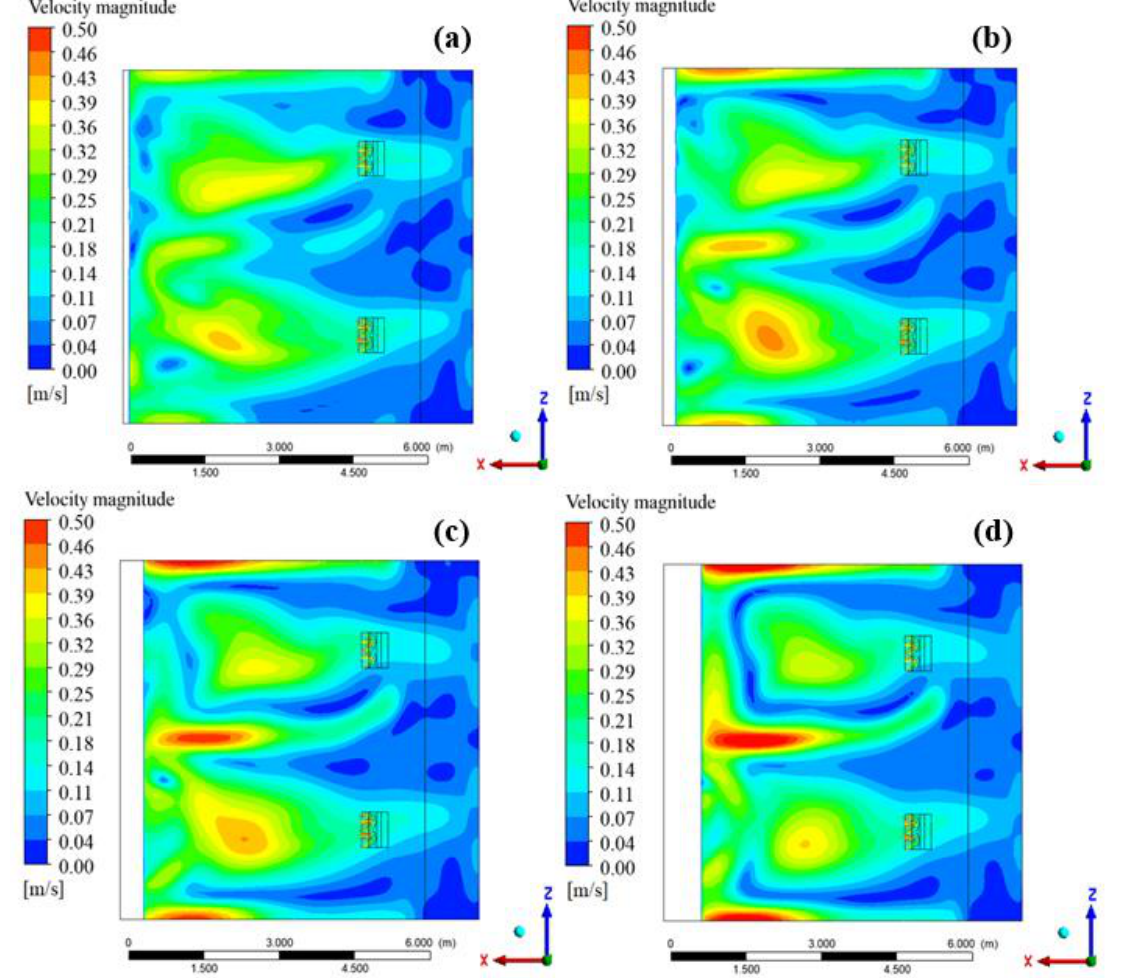
Figure 10. Velocity distribution contours for four horizontal profiles: plane 1 — 0.7 m ( a ), plane 2 — 1.0 m ( b ), plane 3 — 1.3 m ( c ), and plane 4 — 1.6 m ( d ).